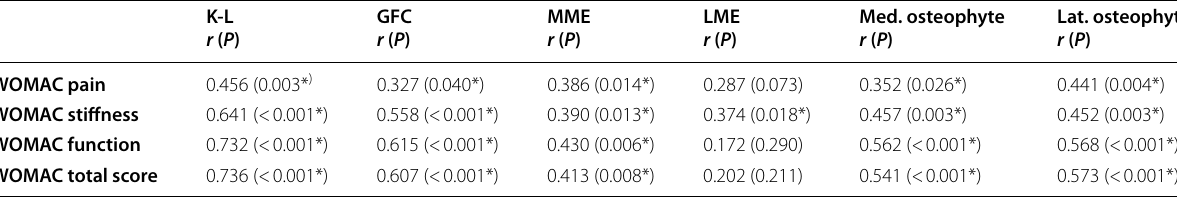
Table 3 Correlation between clinical, radiological, and ultrasonographic parameters